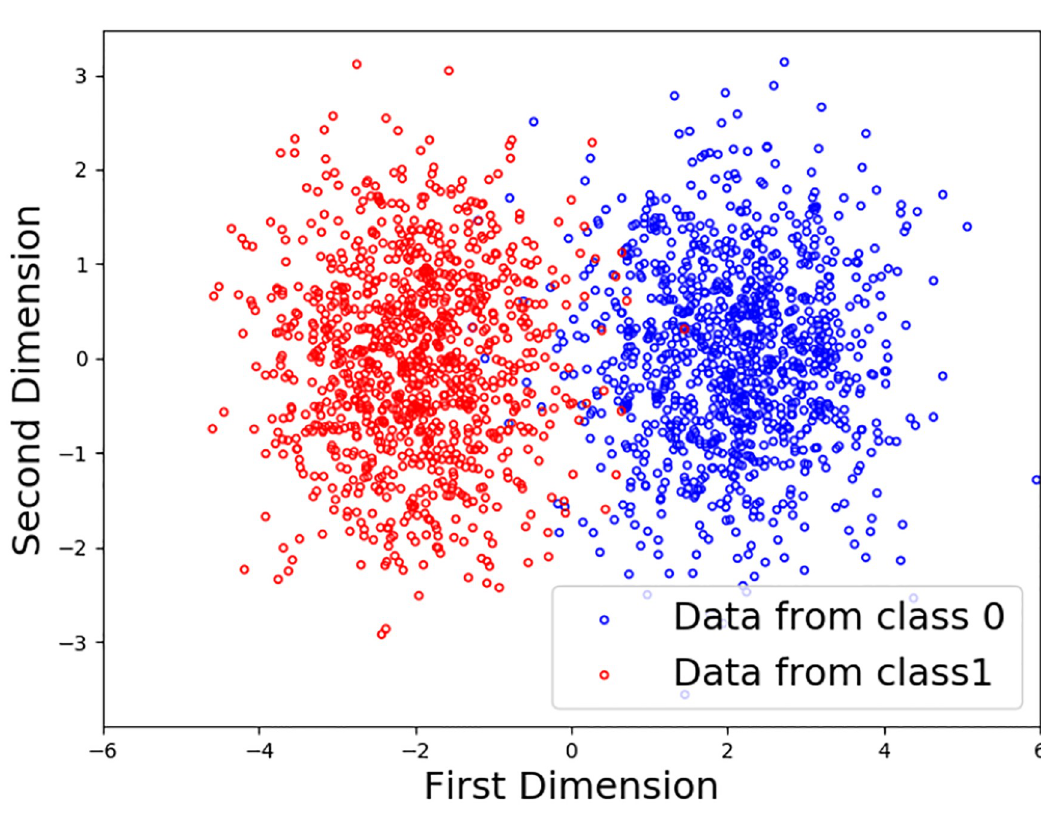
Fig 4. Original data with two